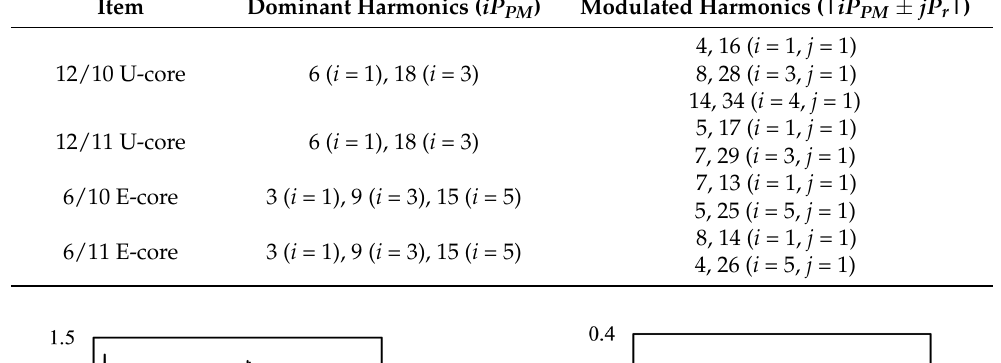
Table 2. Combination of P s and P r for U- and E-core AFFSPM